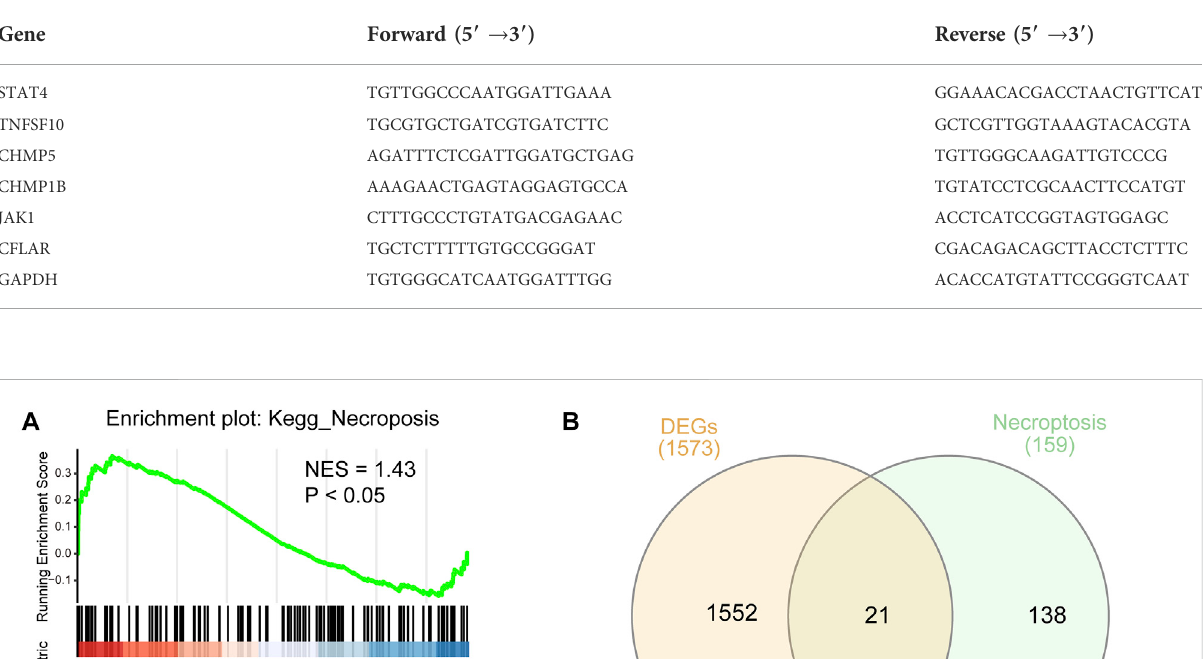
TABLE 1 The sequences of the primers used.